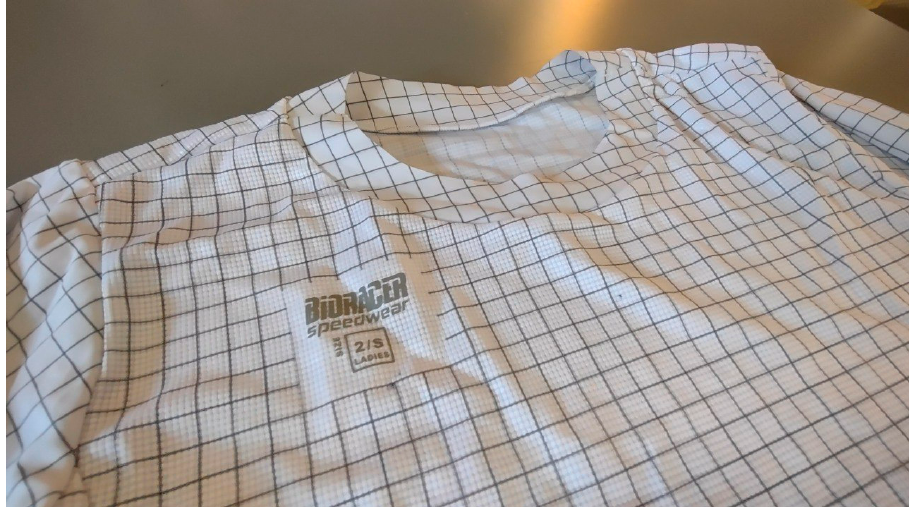
Figure 2. Custom made research garments in the standard confection sizes. The custom print consists of a 1 × 1 cm grid of lines that aid in 3D scanning and measuring of stretch.